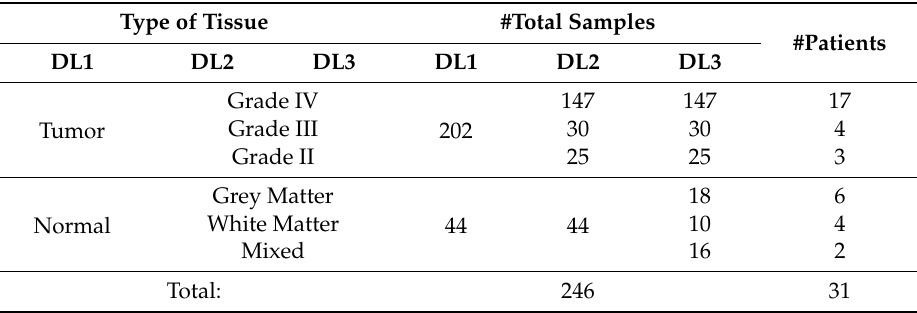
Table 1. Infrared (IR) spectroscopic samples database of human brain tissue. DL1: discrimination level 1, DL2: discrimination level 2, DL3: discrimination level